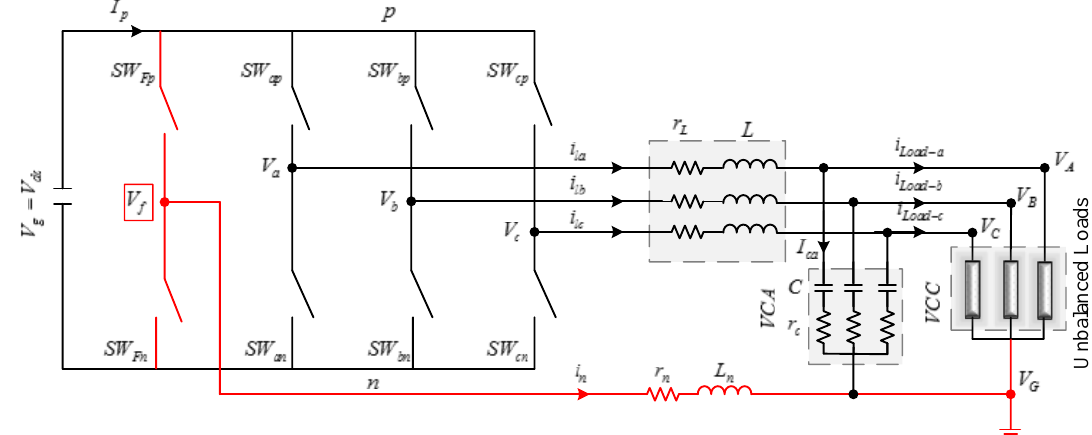
Figure 1. Power stage of a three-phase four-leg voltage source inverter.